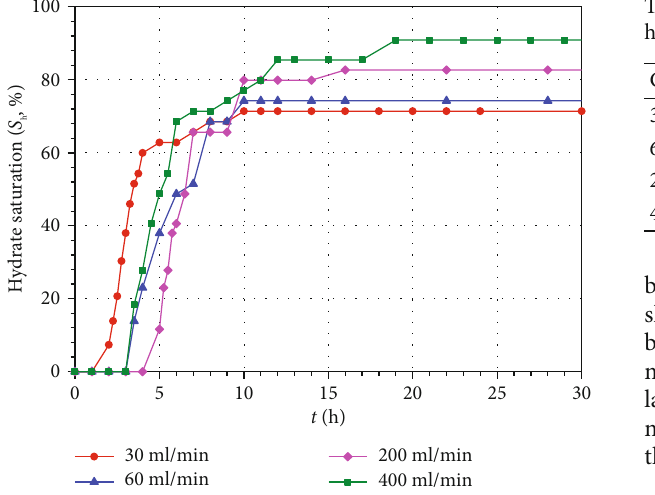
Figure 6: E ff ect of methane fl ux on hydrate formation (Data for Figure 6 are in Table S6 in the Supplementary Materials).